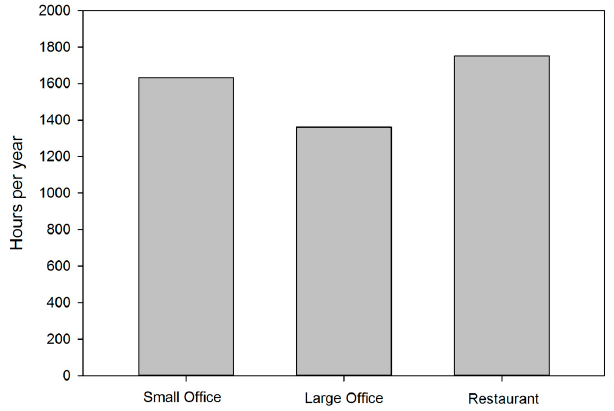
Figure 4. Number of hours that energy is supplied by the battery to each of the evaluated buildings in one year.